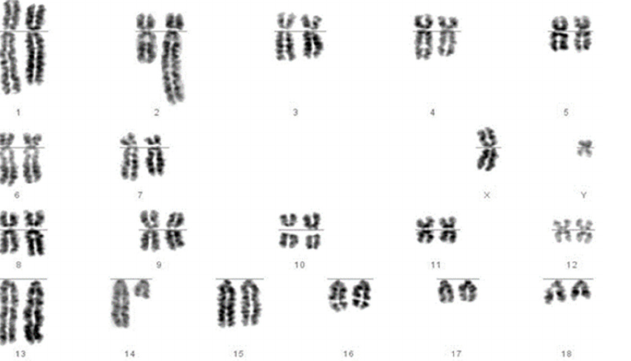
Table 1. Summary of porcine screening results from 2016–2019 using the multiprobe FISH method and standard karyotyping.